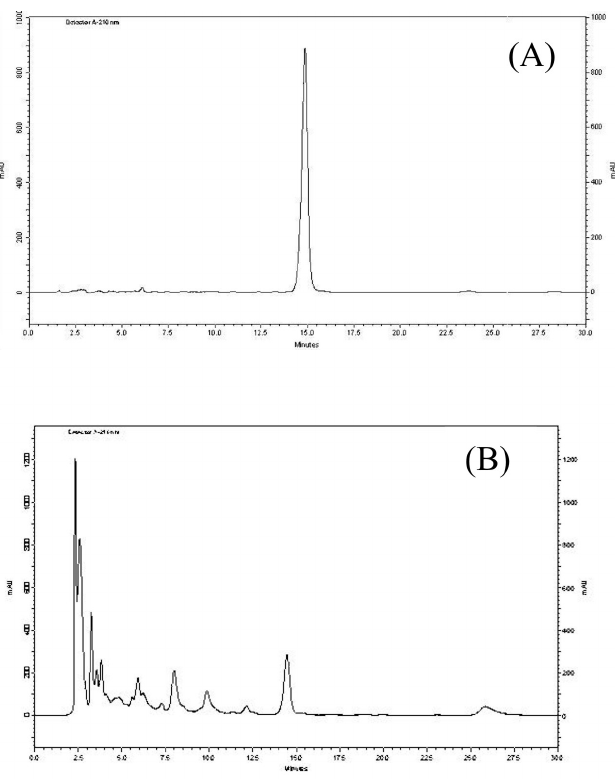
FIGURE 1 - HPLC/DAD chromatograms of parthenolide analyses, mAU x Time (min): (A) parthenolide standard; (B) spray-dried extract from feverfew. Mobile phase: acetonitrile: water (45:55). Flow-rate: 1 mL/min. Detection at 210 nm.